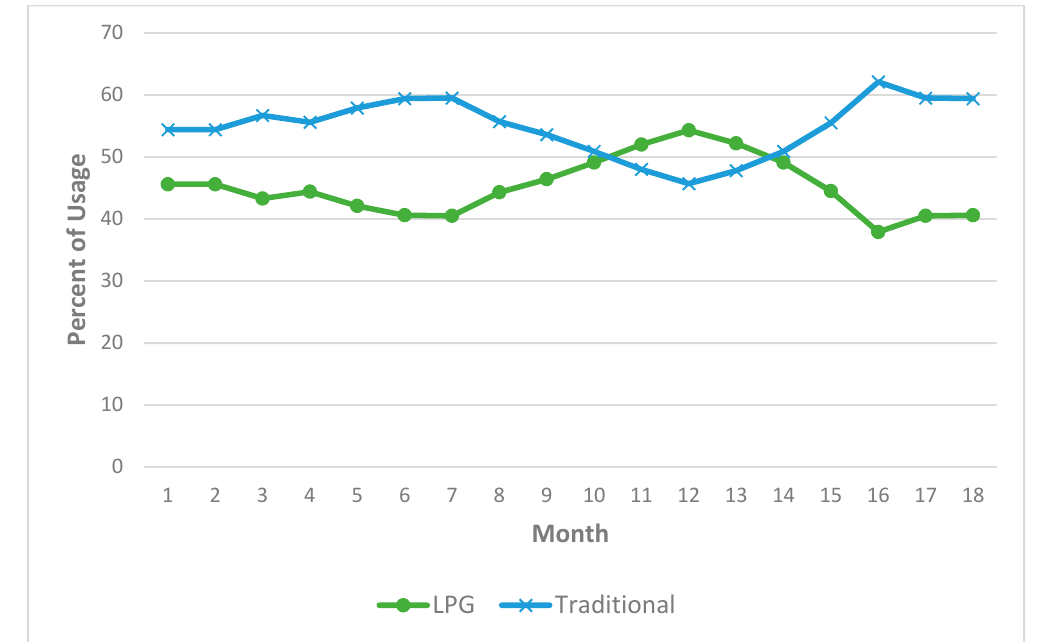
Figure 2. Average number of hours of LPG and Traditional Stove use per month for all study house- holds over 18 months of monitoring.